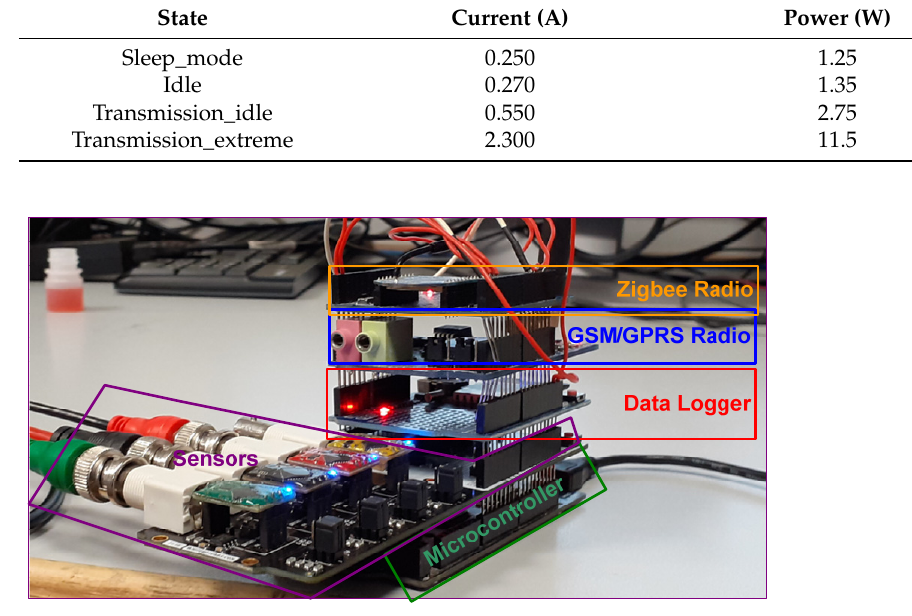
Figure 5. SCU early prototype.